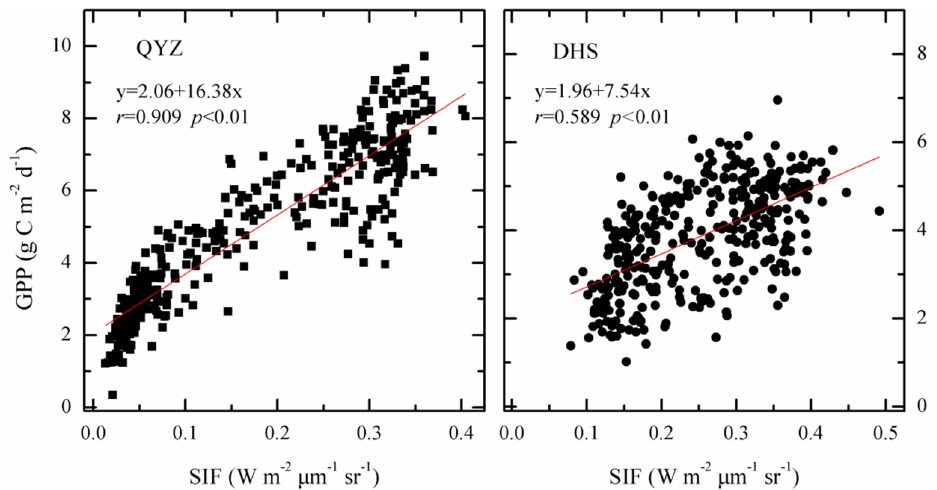
Figure 5. Relationships between 8-day mean tower-based GPP and the associated SIF product at the two subtropical forest (QYZ, evergreen needleleaf forest; DHS, Evergreen broadleaf forest) flux sites. The red line is linear regression. Table 2. Accuracy assessment of the model-estimated GPP relying on time-series SIF data at the two subtropical forest flux sites through leave-one-out cross-validation